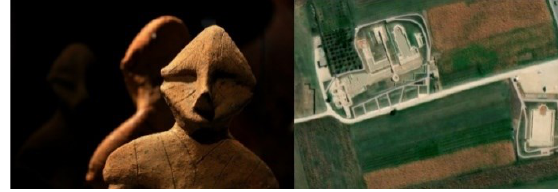
Figure 4 . Hyjnesha Ne Fron, goddess, by Arben Ilaphastica (left) and the aerial view from Ulpiana archaeological site. Sources: https://twitter.com/illyriens and Carto database (right).